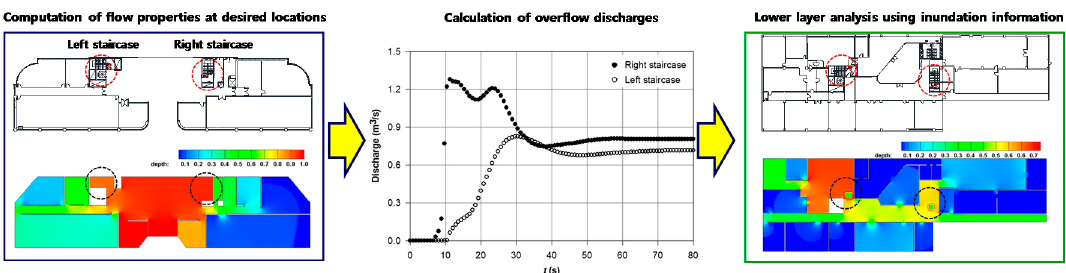
Figure 8. Analysis procedure for connecting inundation in two layers.